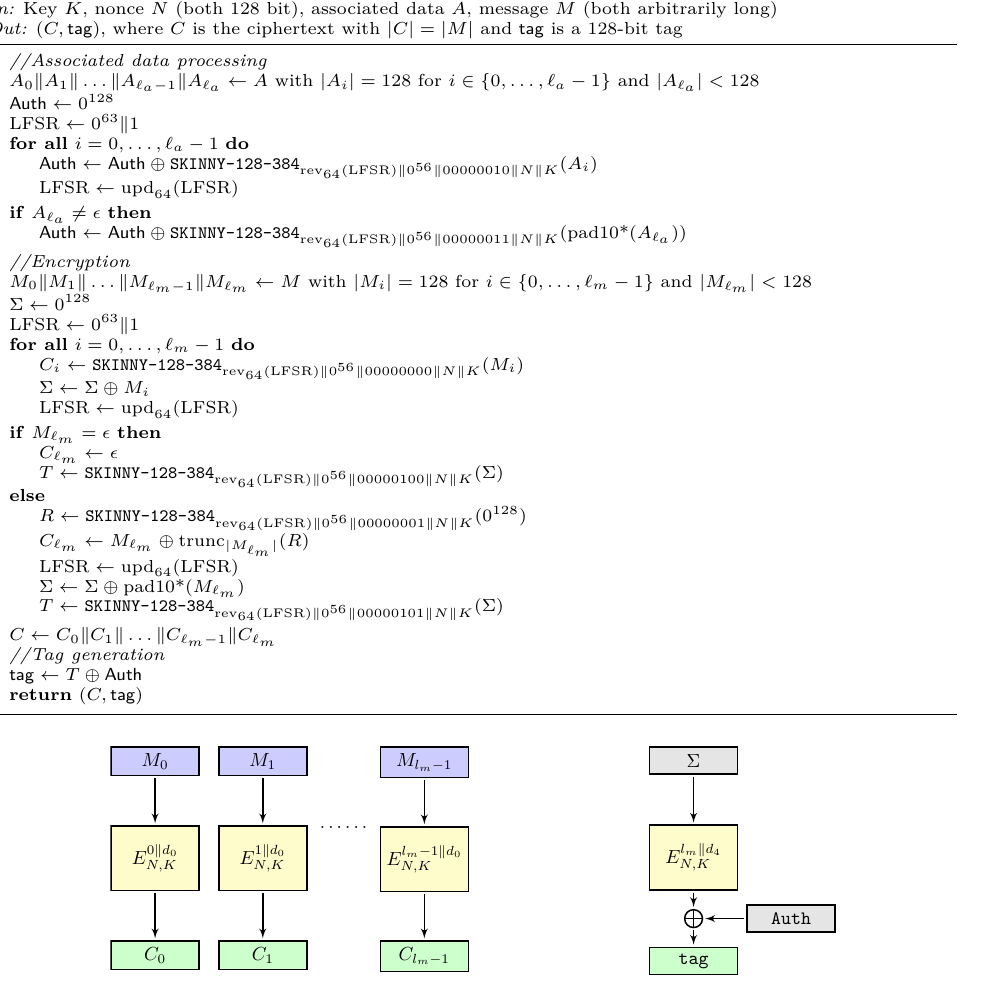
Figure 4: Encryption of SKINNY-AEAD with SKINNY-128-384 without padding